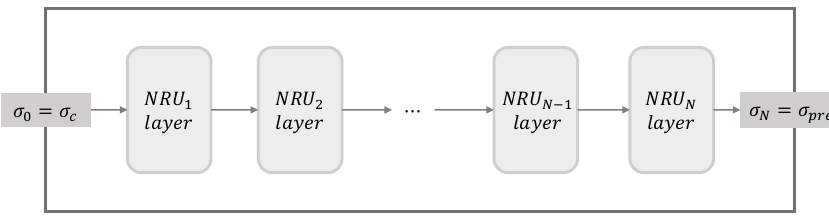
Figure 2. Newton–Raphson (NR) emulation network.